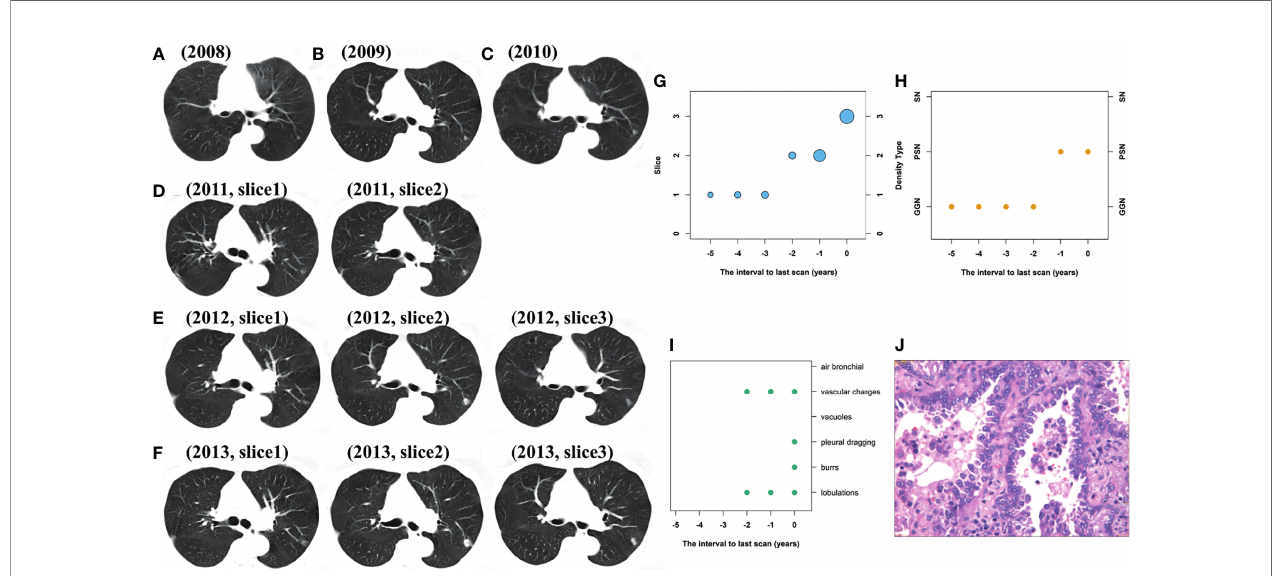
FIGURE 7 | Female patients, 57 years old at baseline scan; the pathology result is invasive adenocarcinoma. (A – F) Are the annual screening CT images from 2008 to 2013; (G – J) are the changes in size, density, morphological signs, and pathology, respectively. From the baseline scan to the last scan, the lesion changed from 1 slice to 3 slices, the density changed from GGN to PSN. There are no poor morphological signs at the baseline and start to appear in follow-up scan.